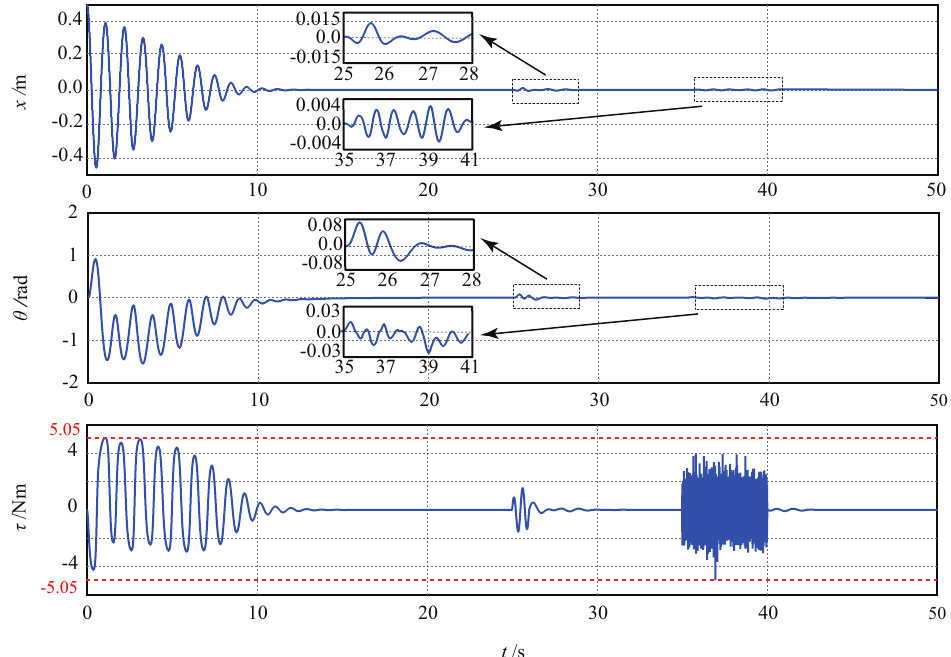
Figure 5. Simulation results of the TORA system with external disturbances and parameter